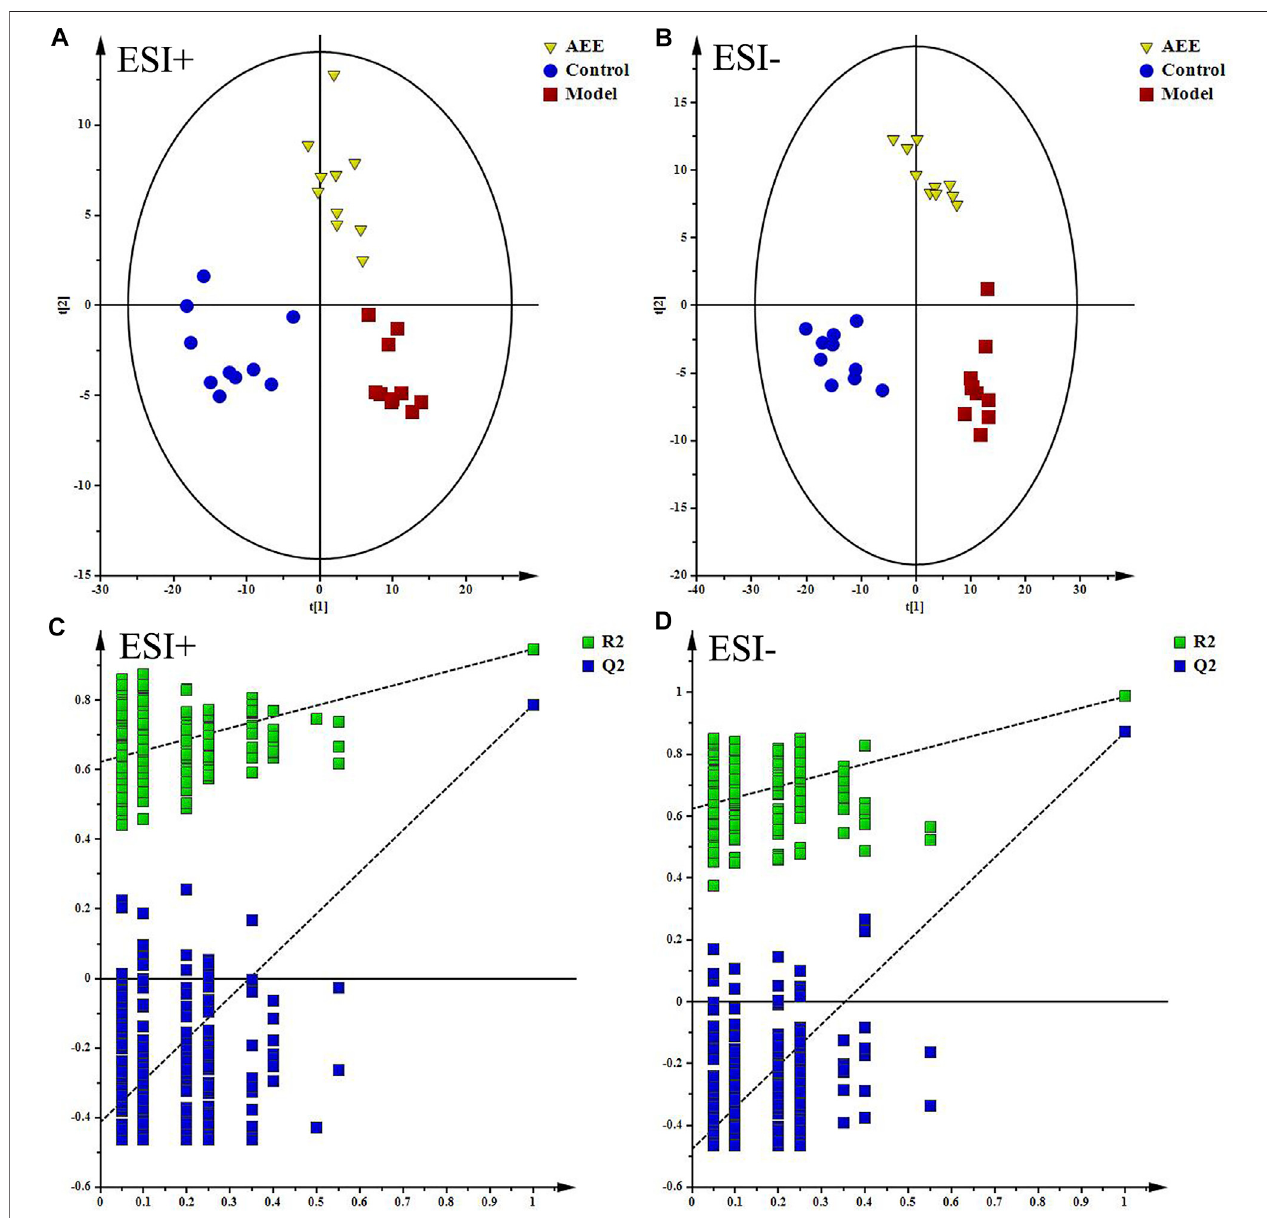
FIGURE 1 | Effect of AEE on metabolomic pro fi le of liver in hamster fed with high fat diet. (A,B) PLS-DA score plots of liver samples collected from different treatment groups, ESI+:R 2 X (cid:1) 0.506,R 2 Y (cid:1) 0.961,and Q 2 (cid:1) 0.838; ESI-: R 2 X (cid:1) 0.535, R 2 Y (cid:1) 0.982, and Q 2 (cid:1) 0.919. (C,D) Permutationtest ofPLS-DA models inESI+ and ESI −